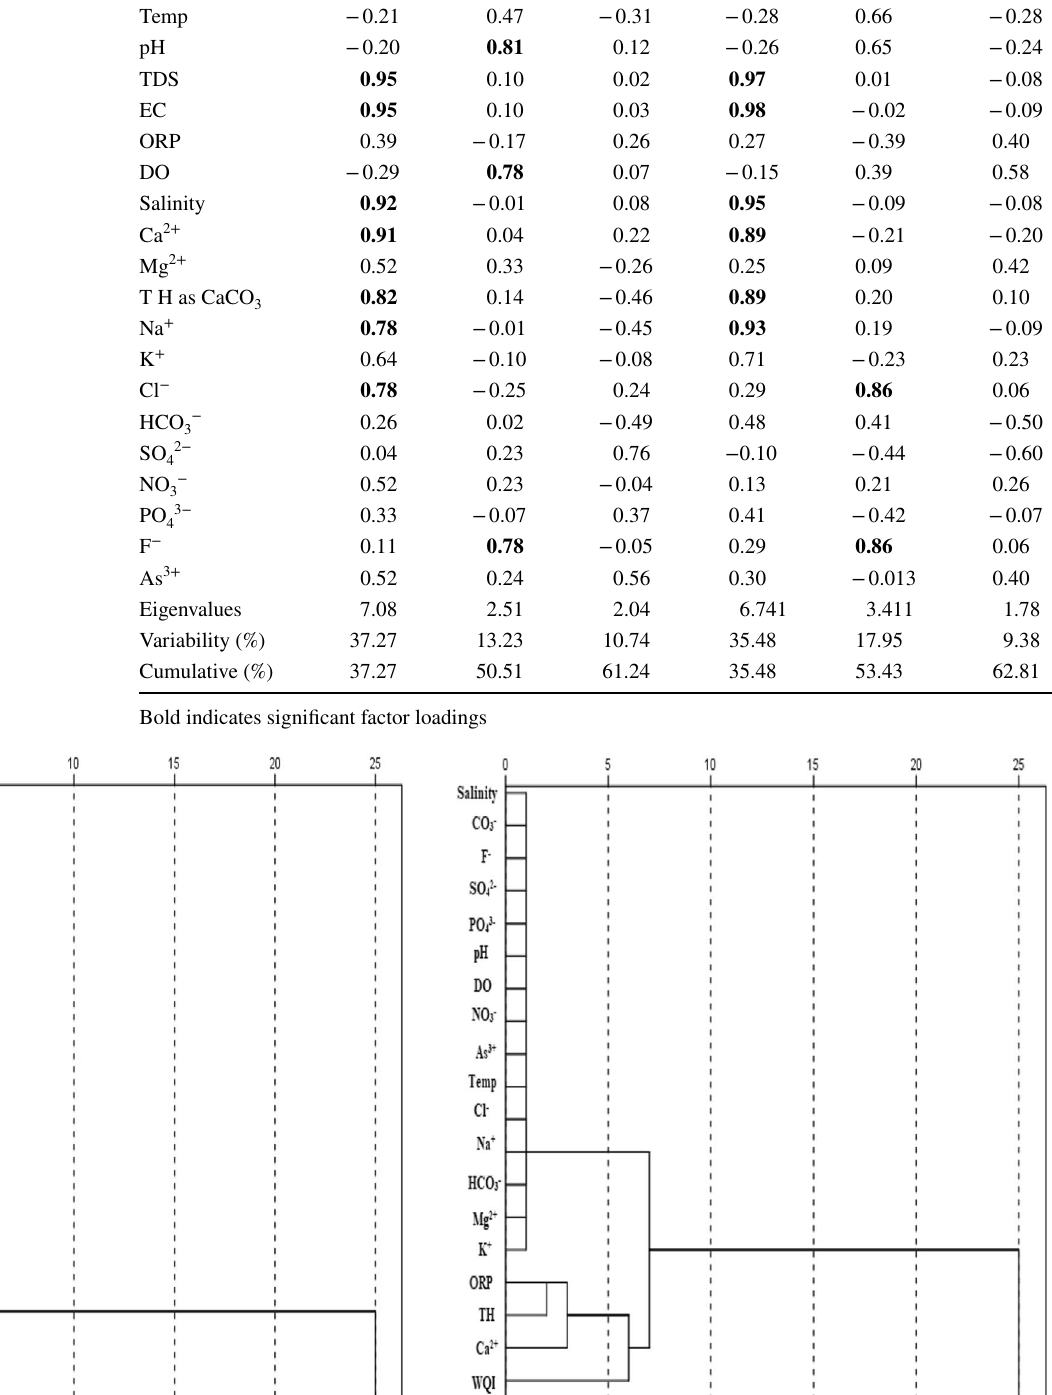
Table 5 Varimax-rotated factor loadings with Eigen values and % of variances for the groundwater quality parameters during PM and PoM seasons